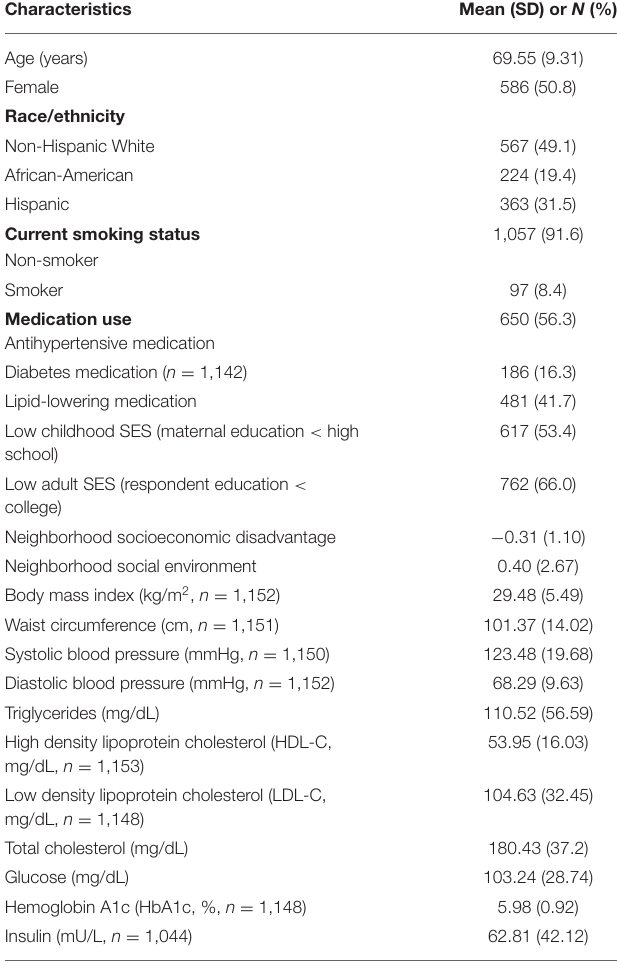
TABLE 1 | Descriptive statistics ( N =